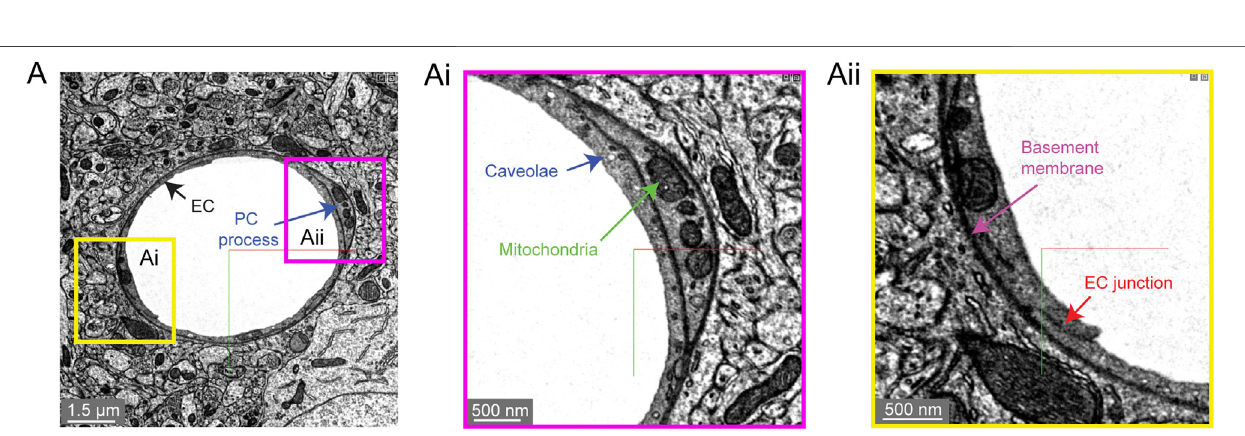
FIGURE 6 | Subcellular structures in the vasculature are visible with high contrast in the MICrONS Layer 2/3 data set. (A) A representative cross-section of a capillary with magni fi ed insets showing commonly measured subcellular structures, including caveolae and mitochondria (Ai) and endothelial junctions and basement membrane (Aii) . MICrONS Layer 2/3 x, y, z coordinates at: 109802, 58170, 707.